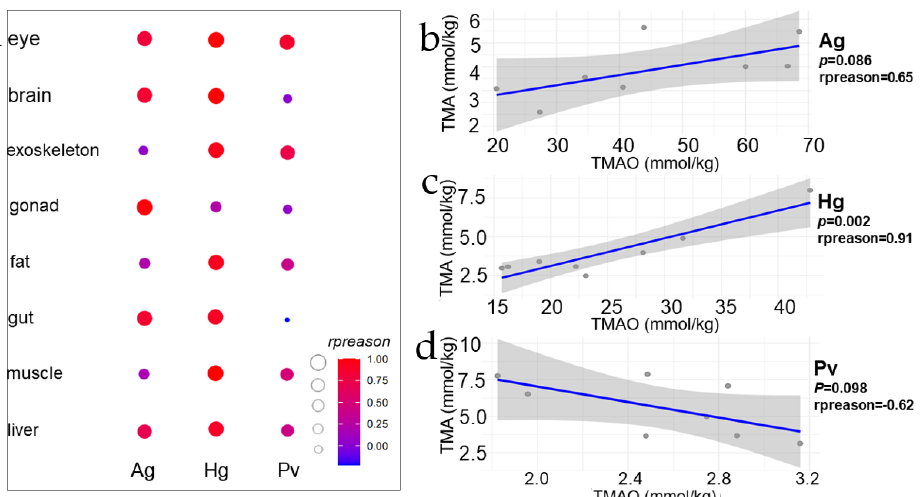
Figure 4. TMAO – TMA correlation comparison and fitting curve. ( a ) represents the TMAO-TMA correlation scatter plot of each tissue of the two hadal amphipod species, and the size and color of each point represent the magnitude of correlation coefficient. ( b – d ) represents the fitting curve of the order of A. gigantea , H. gigas and P. vannamei , with Pearson correlation coefficient and p value, respectively.